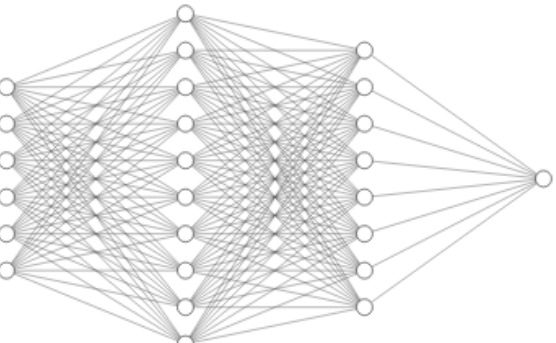
Figure 9. Generic diagram of a fully connected feedforward neural network. In our application, an example of such a network for the FR case may have 6 Input nodes, 80 nodes in Hidden Layer 1, 64 nodes in Hidden Layer 2, and 1 Output node. We often use ReLu activation and RMSProp for optimization, and sigmoid activation at the Output layer. In the NR case, the number of Inputs, and thus the size of the network, are substantially larger. Diagram constructed using